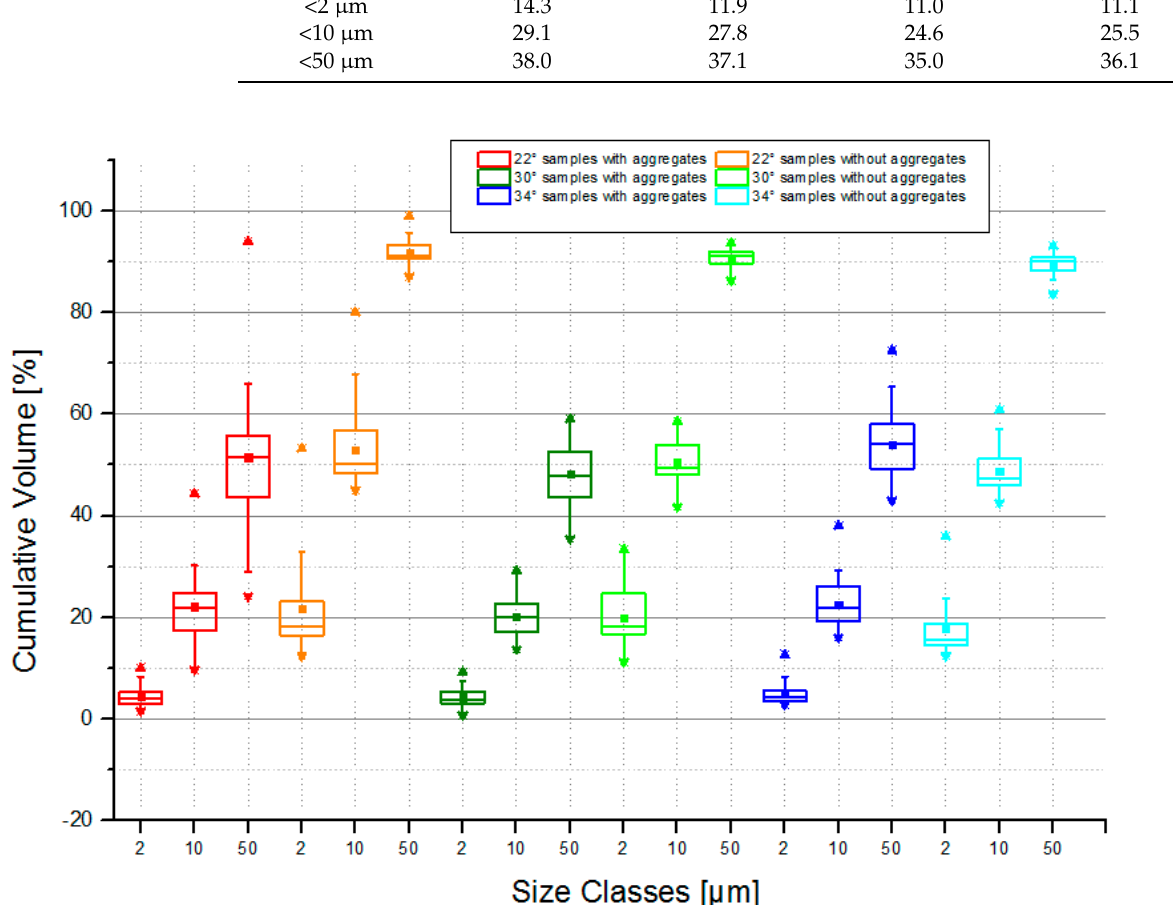
Figure A2. Boxplot representation of influence of slope of the experimental plot to the PSD (obtained by LD).